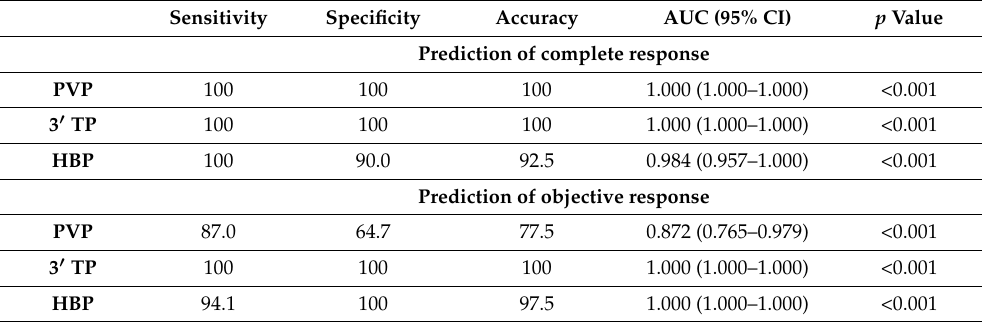
Table 3. Performance of logistic model with ridge penalty (radiomics model 1) based on the selected features for predicting complete response and objective response (complete and partial response) in the training set.